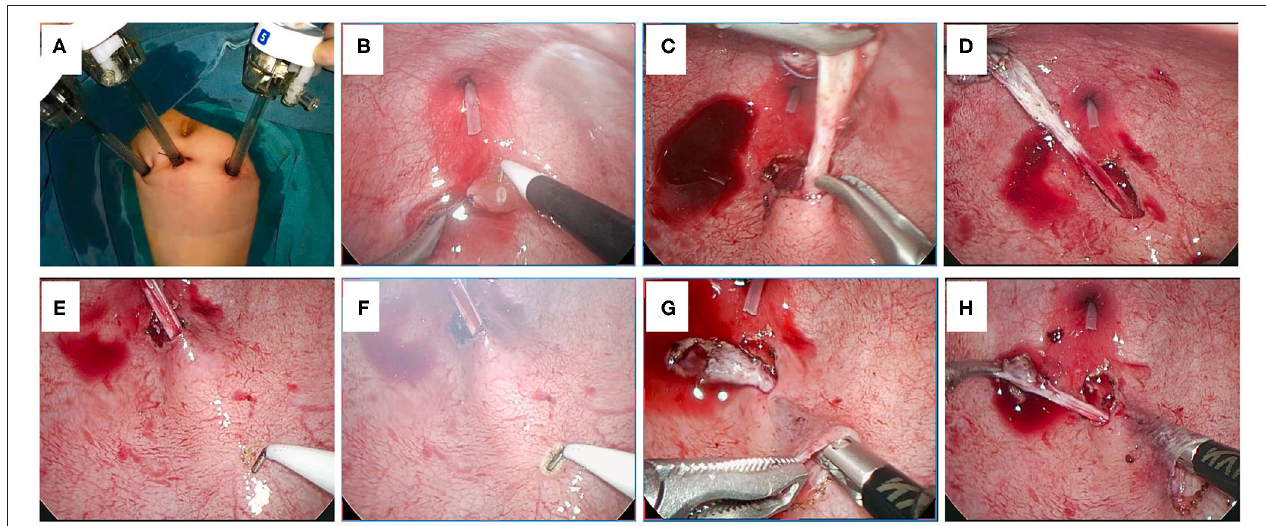
FIGURE 1 | (A) The position of the trocars. (B) The ureteral orifice is sutured for pulling. (C,D) The distal ureter is mobilized to obtain an adequate length. (E) The distal ureter is gently pulled to show the course of the ureter. (F) The mucosa of the selected proximal new hiatus is dissected by an electric hook. (G,H) Establishment of the submucosal